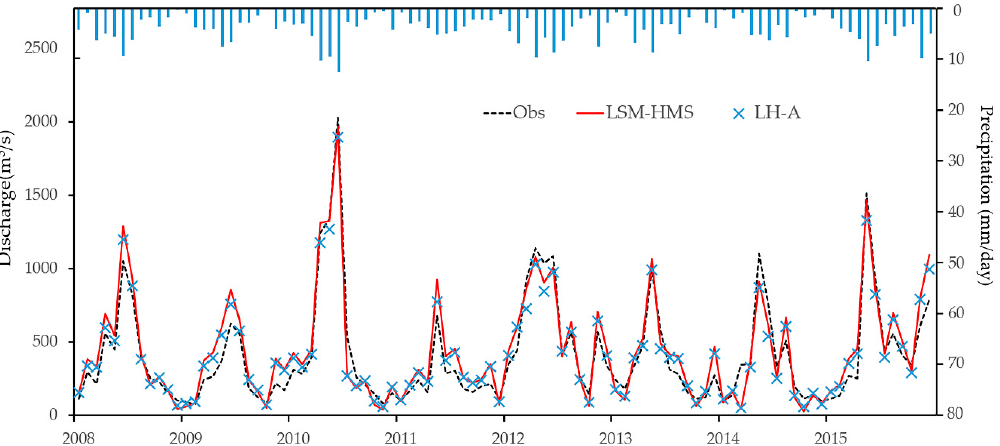
Figure 5. Monthly observed discharge and simulated discharge of China Meteorological Assimilation Driving Datasets for the SWAT model (CMADS)-driven LSM-HMS and all-reservoir condition (LH-A) in Xiashan during 2008–2015.